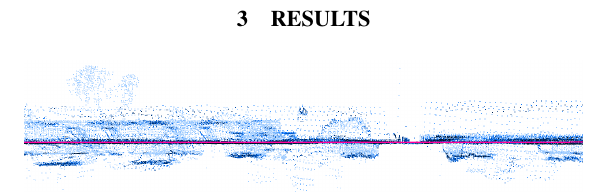
Figure 13: Top view of a facade. Detected line (pink).